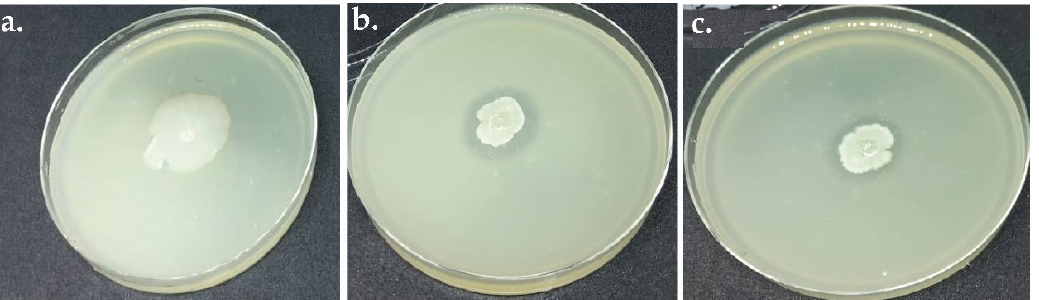
Figure 1. Formation of a pectin hydrolysis zone by alkalophilic pectinase-producing bacteria, APPB1 ( b ) and APPB2 ( c ), compared with a no hydrolysis zone ( a ).